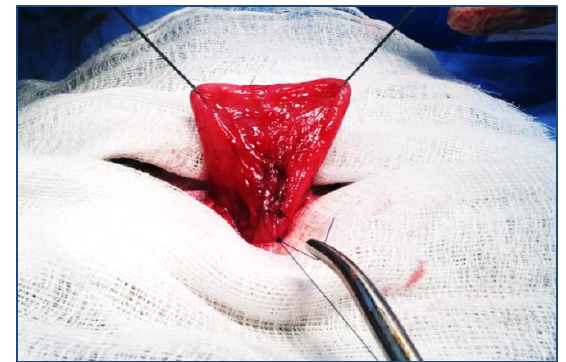
Figure, 4: In the second group, the bladder incision is closed by single-layer of (simple interrupted suture) using Polydioxanone (3/0).